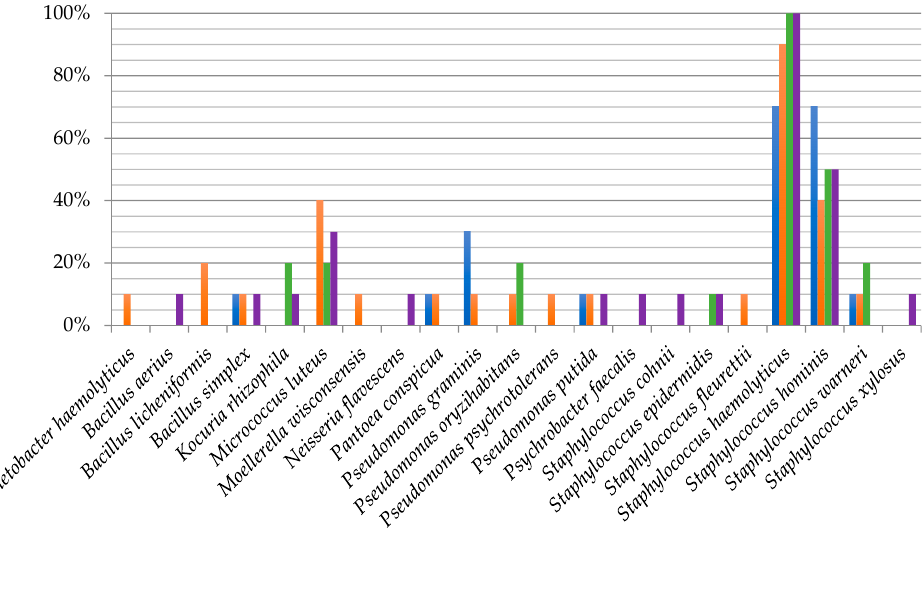
Figure 4. Frequency of the occurrence of fungi on the foot skin depending on the age of examined people.